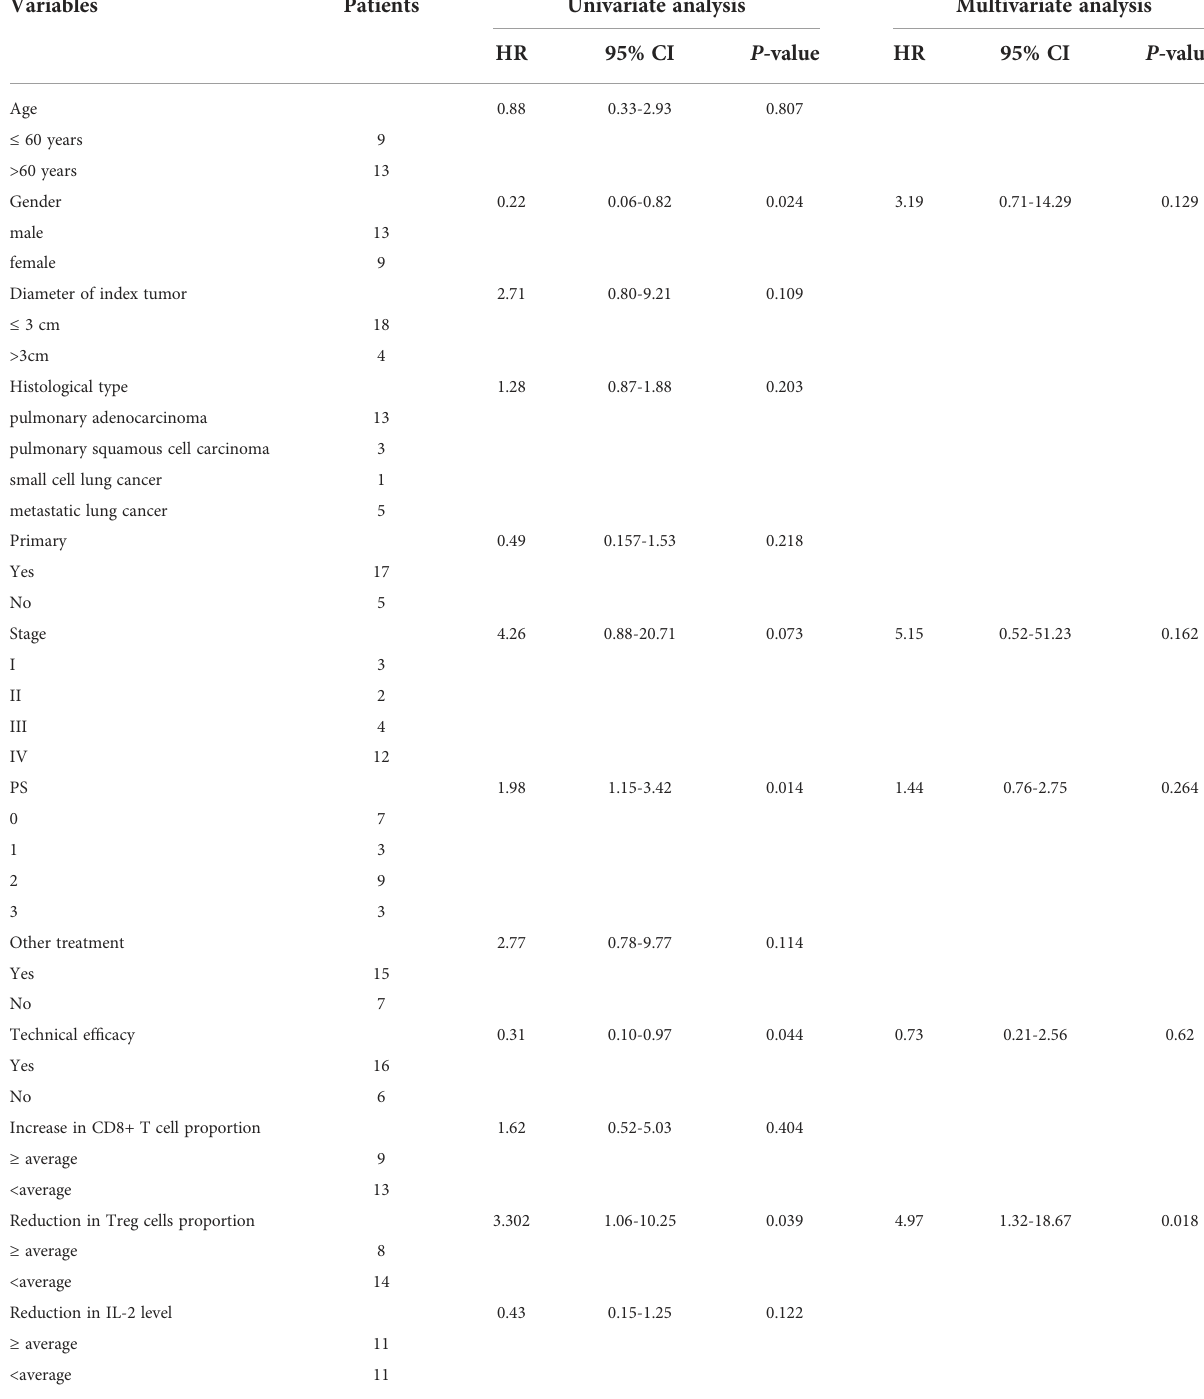
TABLE 3 Univariate and multivariate Cox regression analyses of variables potentially associated with